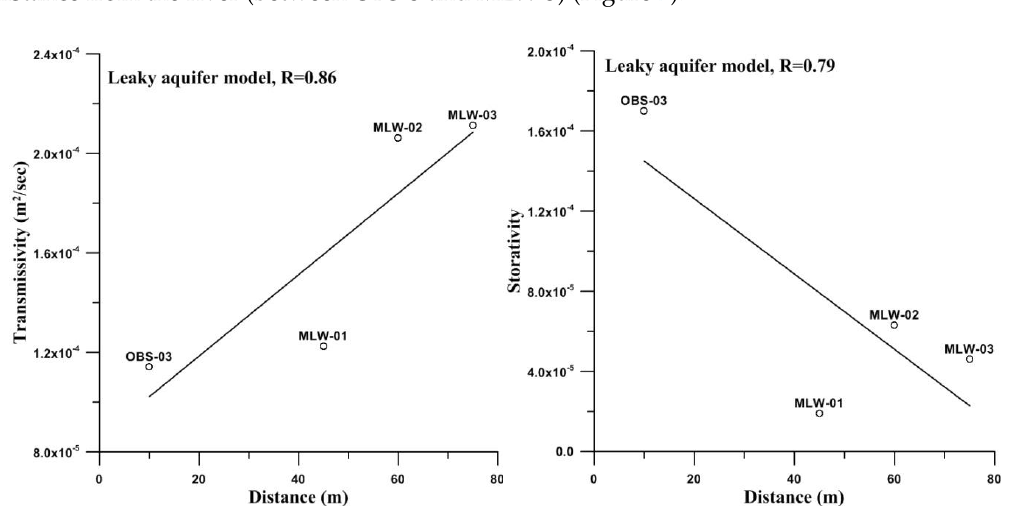
Figure 7. T vs. S at observational wells at various distances from the PW well.